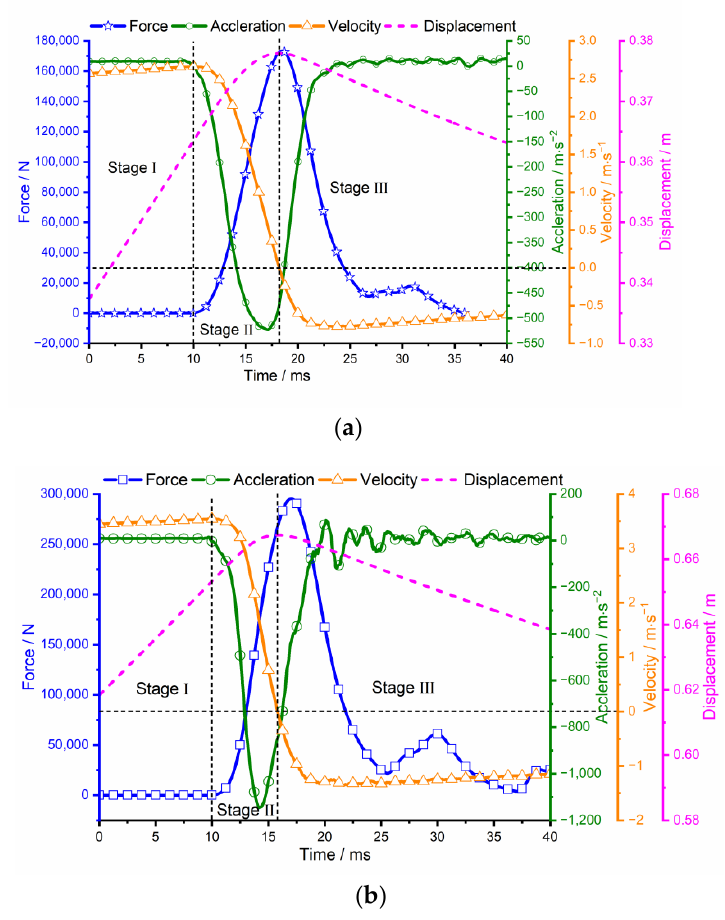
Figure 10. Drop-weight test results of the battery module in Z+ orientations. ( a ) Test results of the battery module in the Z1+ orientation; ( b ) Test results of the battery module in the Z2+ orientation.